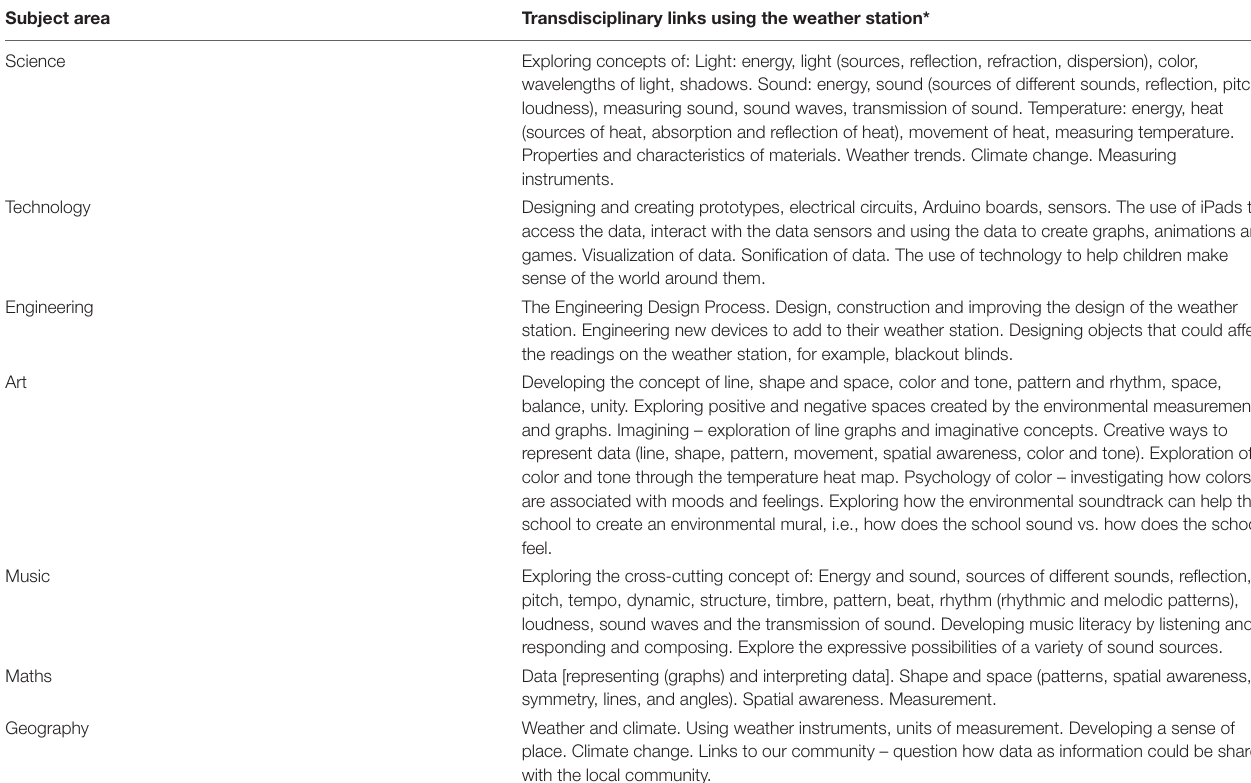
TABLE 1 | Transdisciplinary concepts explored in STEAM lessons using an IoT based Environment Monitoring